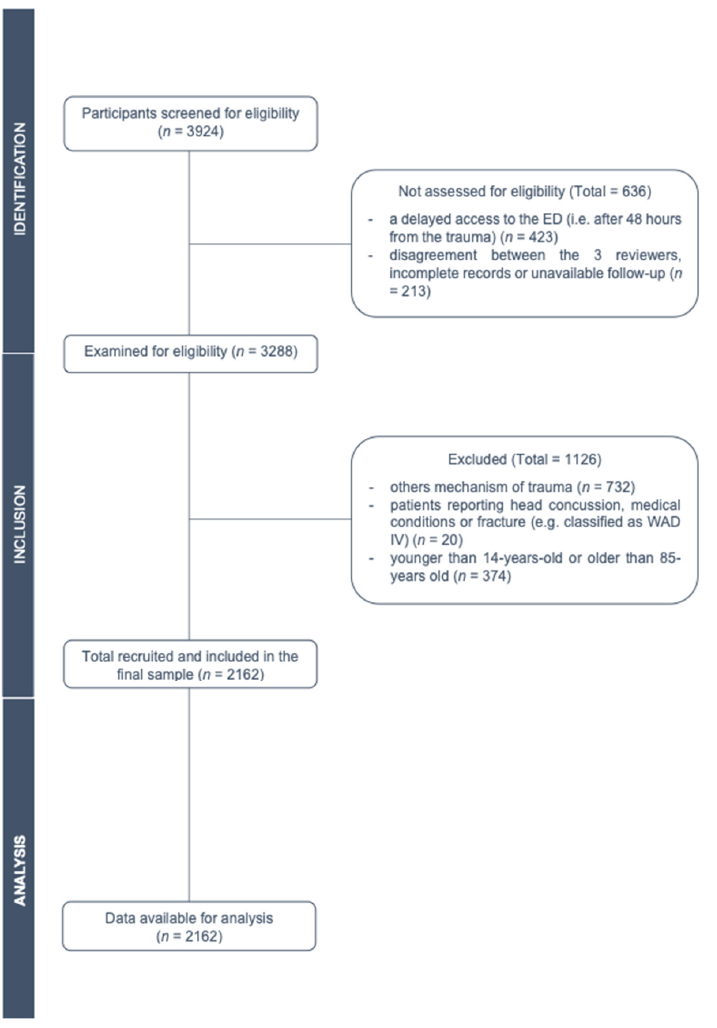
Figure 1. Flow diagram of eligible subjects according to STROBE statement. Table 2. Baseline characteristics and clinical variables.